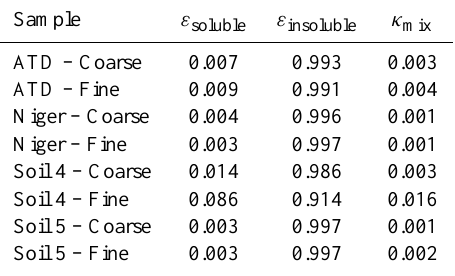
Table 4. Soluble volume fraction ( ε s ) , insoluble volume fraction ( ε i ) , and inferred hygroscopicity parameter ( κ ) for mineral dust aerosol samples. Uncertainties in volume fractions are estimated to being less than